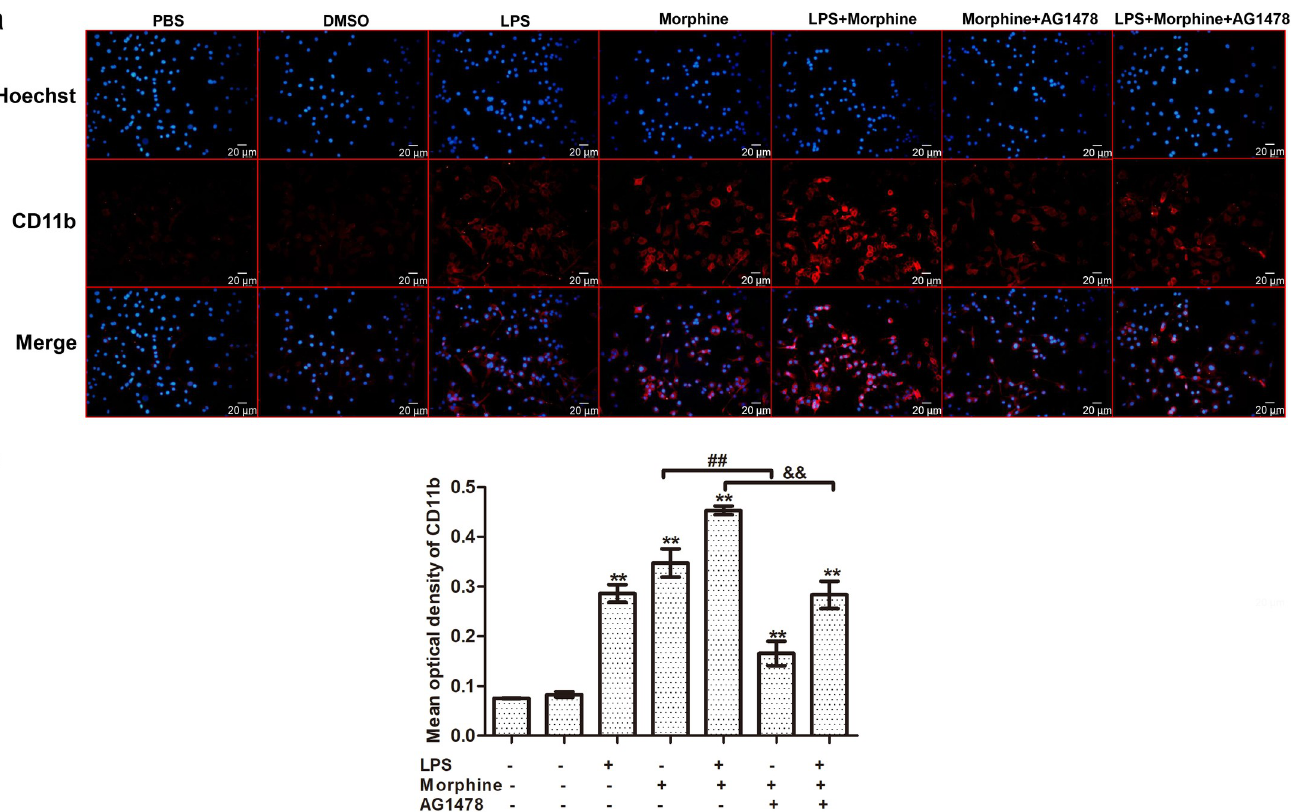
Fig 3. The effect of morphine and LPS on microglial activation by immunocytochemical analysis. (a) BV-2 cells were treated with PBS, DMSO, LPS (1 μ g/mL), morphine (200 μ M),LPS (1 μ g/mL)+ morphine (200 μ M),morphine (200 μ M)+ AG1478 (10 μ M),and LPS (1 μ g/mL)+ morphine (200 μ M)+ AG1478 (10 μ M)for 6 h. Cells were stained for the activation marker CD11b. Scale bar: 20 μ m.(b) The mean optical densities of six randomly selected fields of cells from each group were analyzed by ImageJ software for quantitative analysis. Data are expressed as the means ± SEMs. All data were analyzed using ANOVA. � p < 0.05 and �� p < 0.01 compared to the control groups. # p < 0.05 and ## p < 0.01 morphine vs. morphine + AG1478. & p < 0.05 and && p < 0.01 LPS + morphine vs. LPS + morphine +